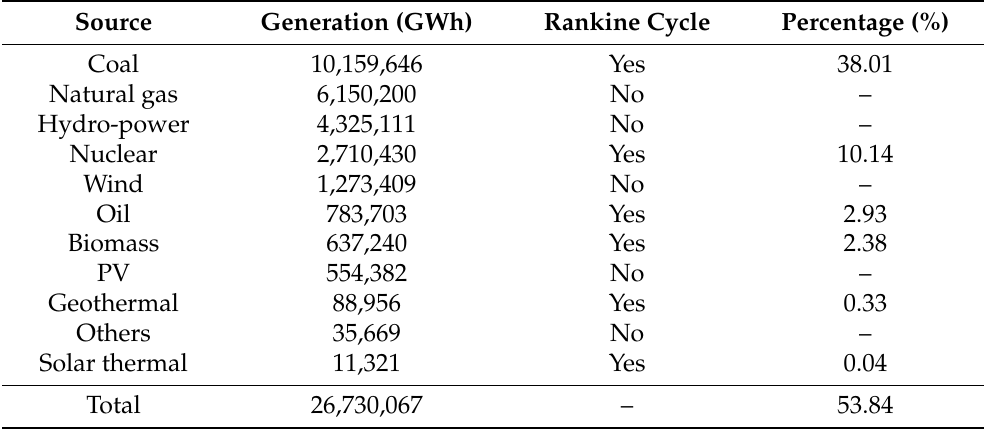
Table 1. Generation by source in 2018